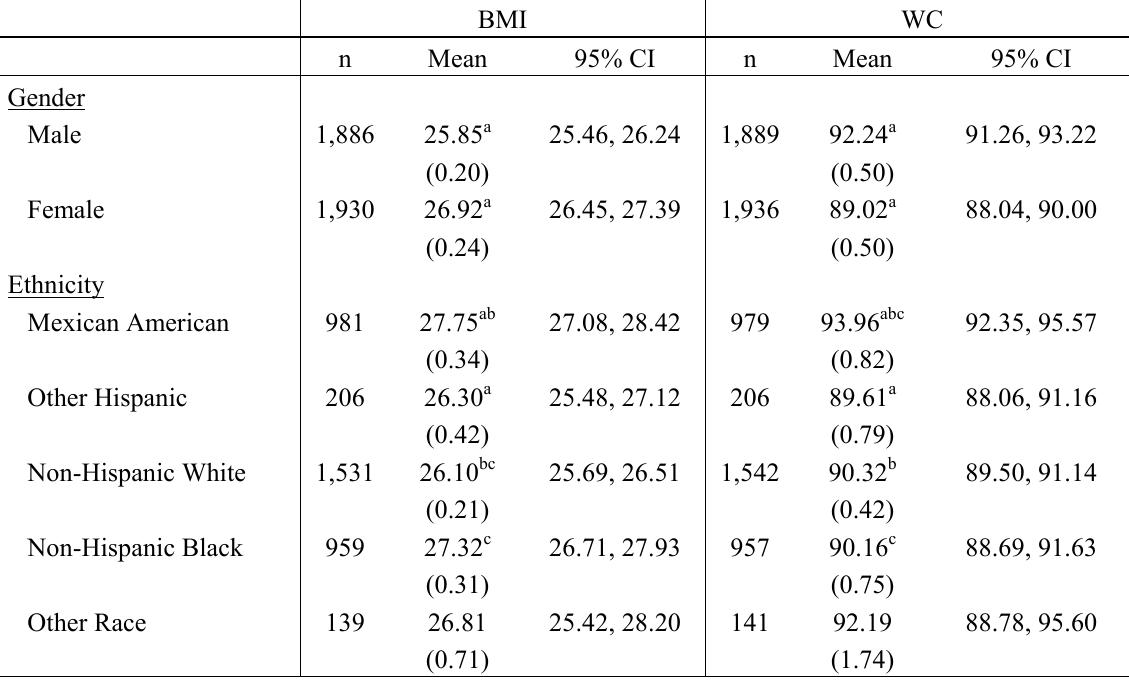
Table 4. Least Squares Means for BMI and WC Additive Models.